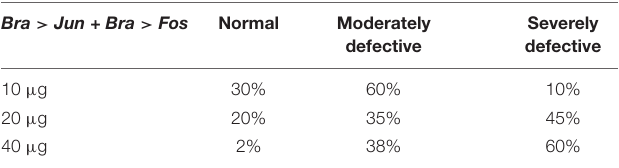
TABLE 1 | Percentages of phenotypic alterations as a function of the amount of Bra > Jun and Bra > Fos electroporated